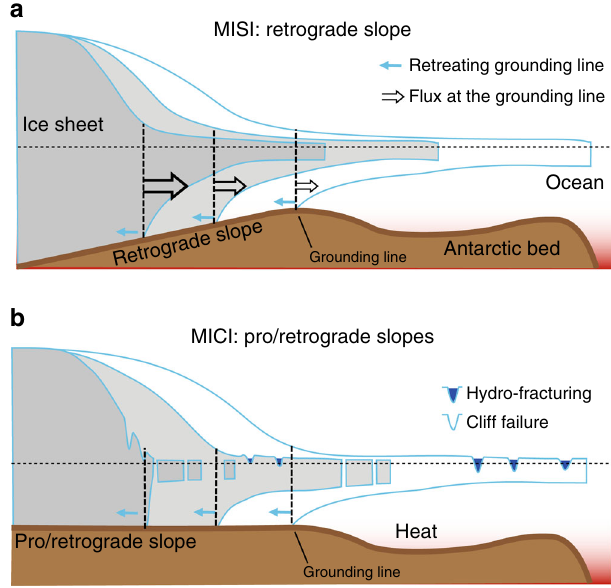
Fig. 1 Instability scenarios. a Marine Ice Sheet Instability versus b Marine Ice Cliff Instability (MICI). Ice discharge generally increases with increasing ice thickness at the grounding line. For a bed sloping down towards the interior this may lead to unstable groundingline retreat (MISI), as increased fl ux (due to reduced buttressing) leads to thinning and eventually fl otation, which moves the grounding line into deeper water where the ice is thicker. Thicker ice results in increased ice fl ux, which further thins the ice, which results in further retreat into deeper water (and thicker ice), and so on. MICI is the result of collapse of exposed ice cliffs (after the ice shelf collapses due to hydro-fracturing) under their own weight. MISI applies for a retrograde slope bed, while MICI can also apply for prograde